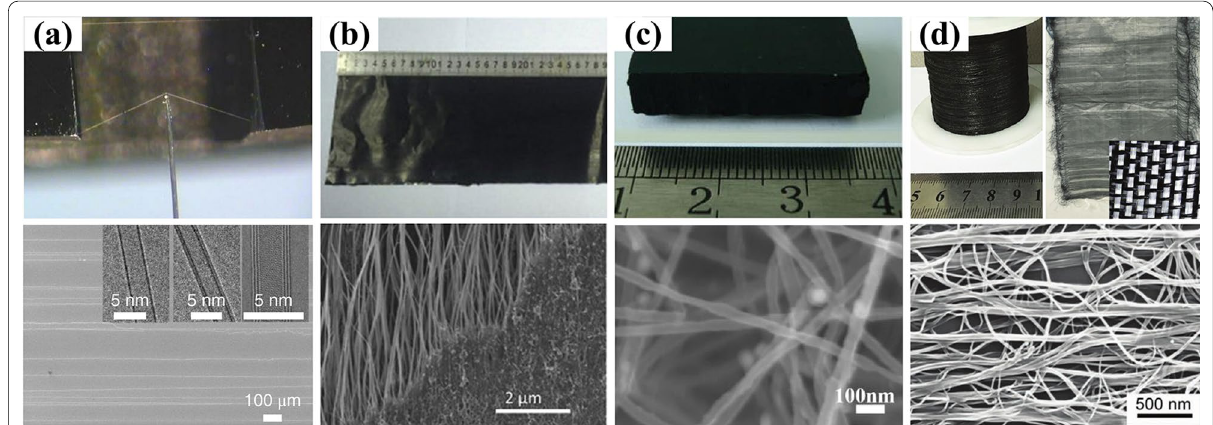
Figure 1 Experimental characterization of four typical constructed CNT networks. SEM images of ( a ) CNT bundles (Inset: high-resolution TEM images of the as-grown ultralong CNTs with single, double and triple walls) [8], ( b ) CNT films [12], ( c ) CNT sponges [13, 14] and ( d ) CNT fibers [9,